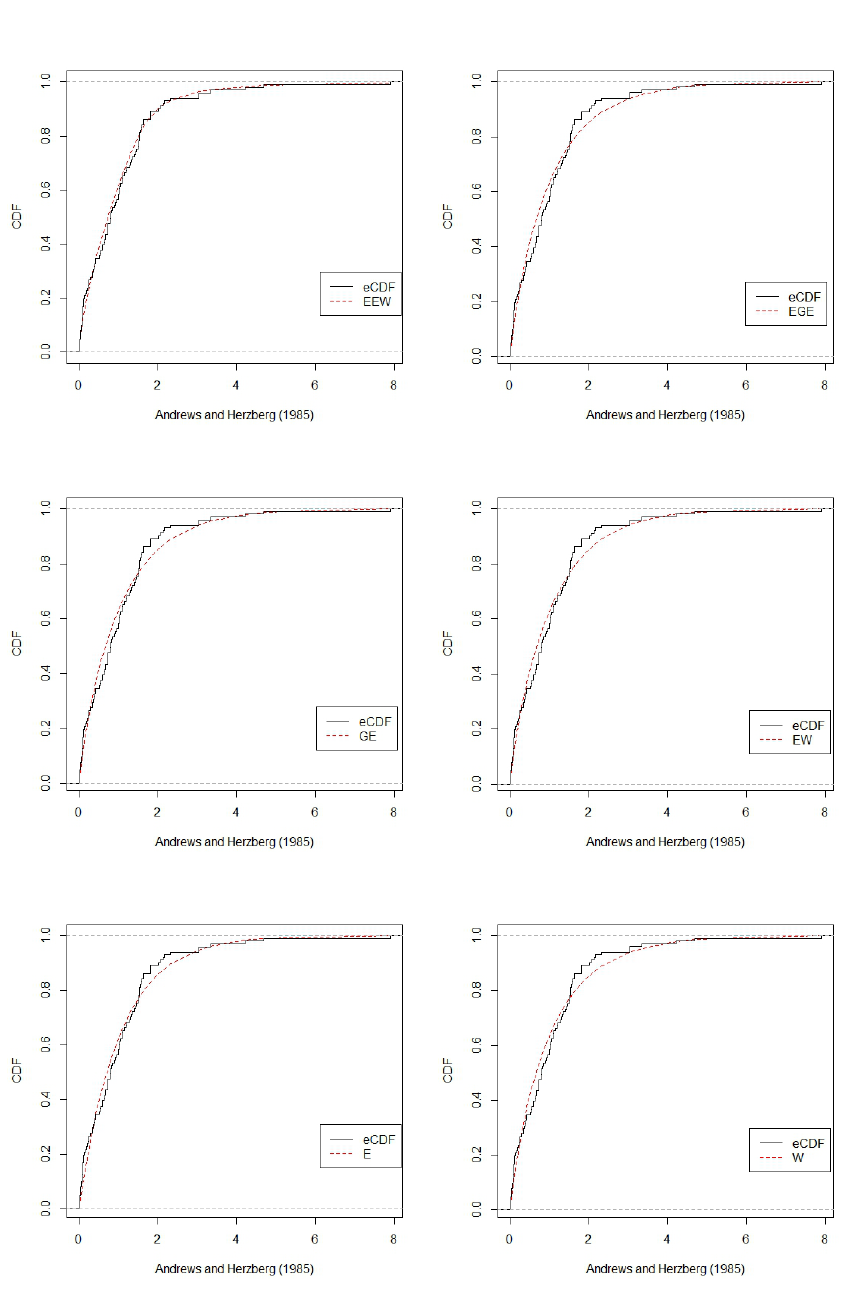
Figure 5 – Estimated distribution function versus the empirical distribution from the fitted EEW, EGE, GE, EW, E and Weibull models for Andrews and Herzberg